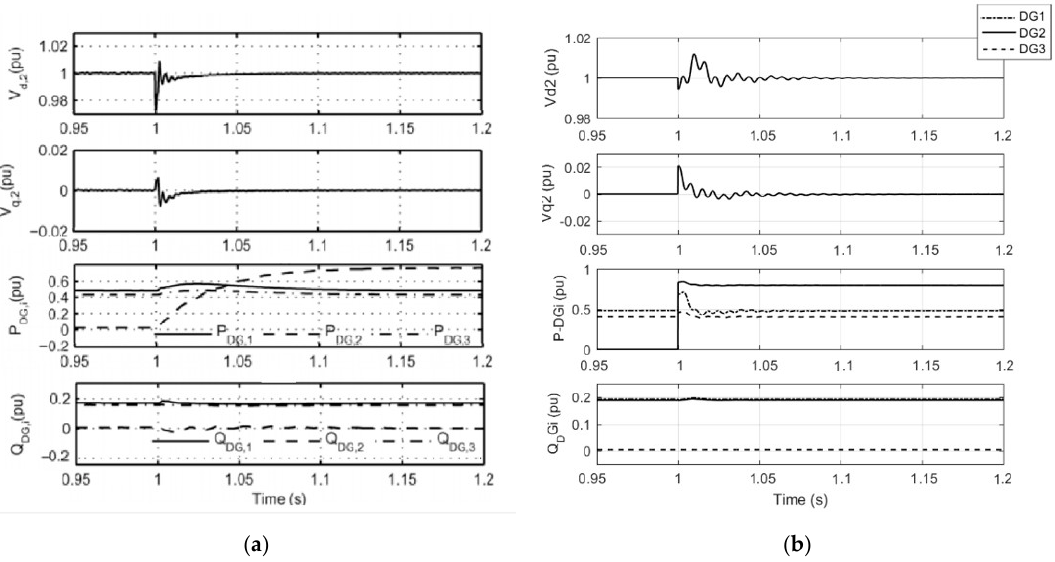
Figure 8. Response for an increase in real power of load2. ( a ) Control of Reproduced from [20], the name of the publisher: IEEE Trans. Power Deliv [20] ( b ) Proposed control. Energies 2020 , 13 , x FOR PEER REVIEW